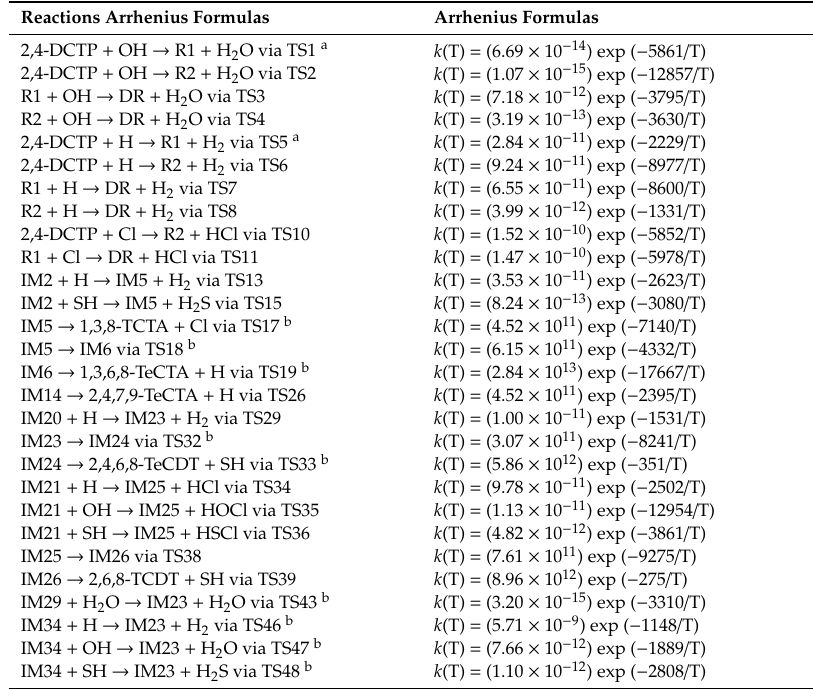
Table 1. Arrhenius formulas for crucial elementary reactions involved in the formation of R1, R2 and DR from the 2,4-DCTP precursor and PCTA / DTs from the R1, R2 and DR precursors over the temperature range of 600–1200 K. (units are s − 1 and cm 3 molecule − 1 s − 1 for unimolecular and bimolecular reactions, respectively. a Reproduced with permission from Xu et al. [39], b Reproduced with permission from Xu et al.